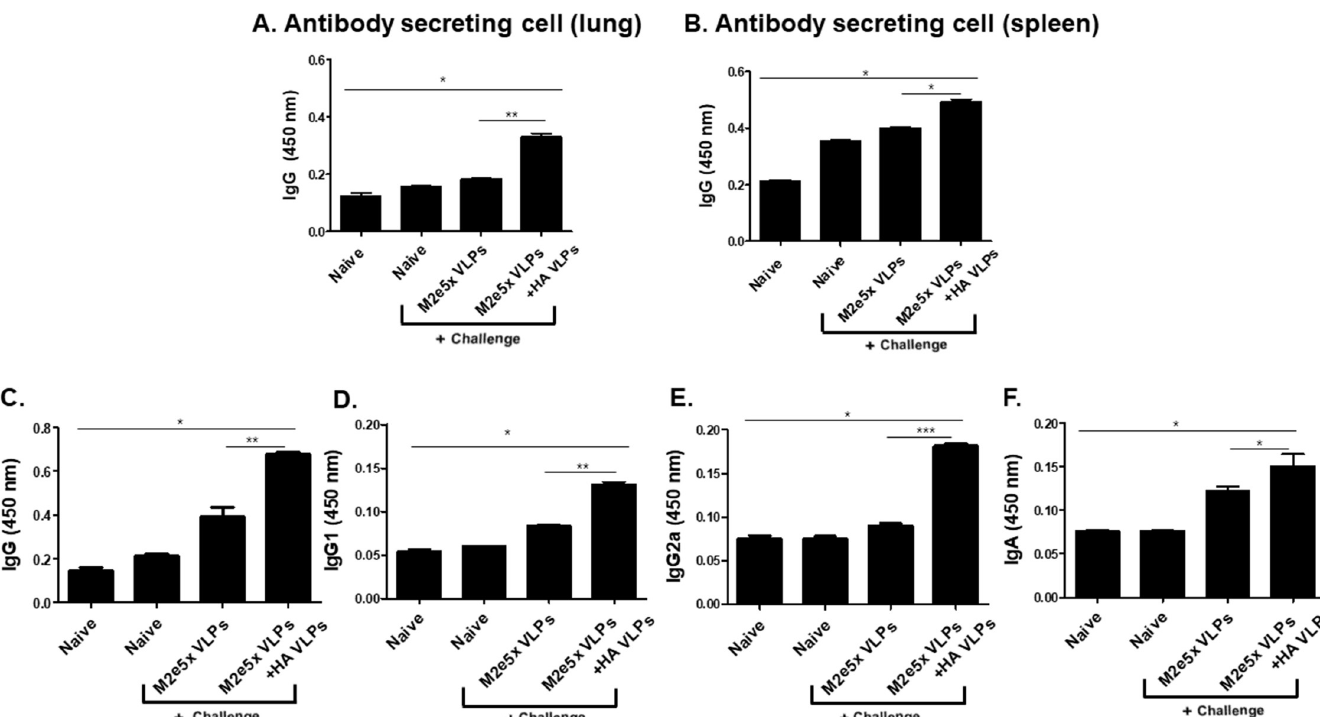
Fig 3. Antibody secreting cell responses (ASCs) from lung and spleen and antibody responses in lungs. Immunized mice were challenge infected with lethal dose of A/Viet Nam/1203/2004 (rgH5N1) virus. At day 4 post-challenge infection, ASCs responses were measured from splenocytes (A) and lung cells (B). Antibody responses from lung extracts were also measured IgG (C), IgG1 (D), IgA (E) and IgG2a (F). Data are expressed as mean ± SD ( � P < 0.05).